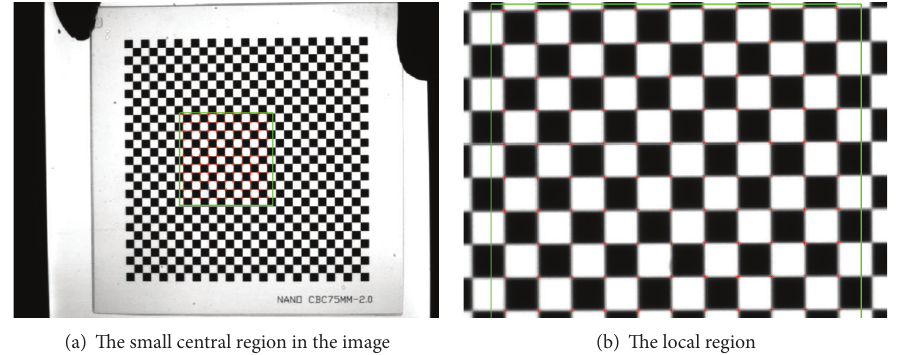
Figure 2: The feather points in the central region of 300 × 300 pixels.